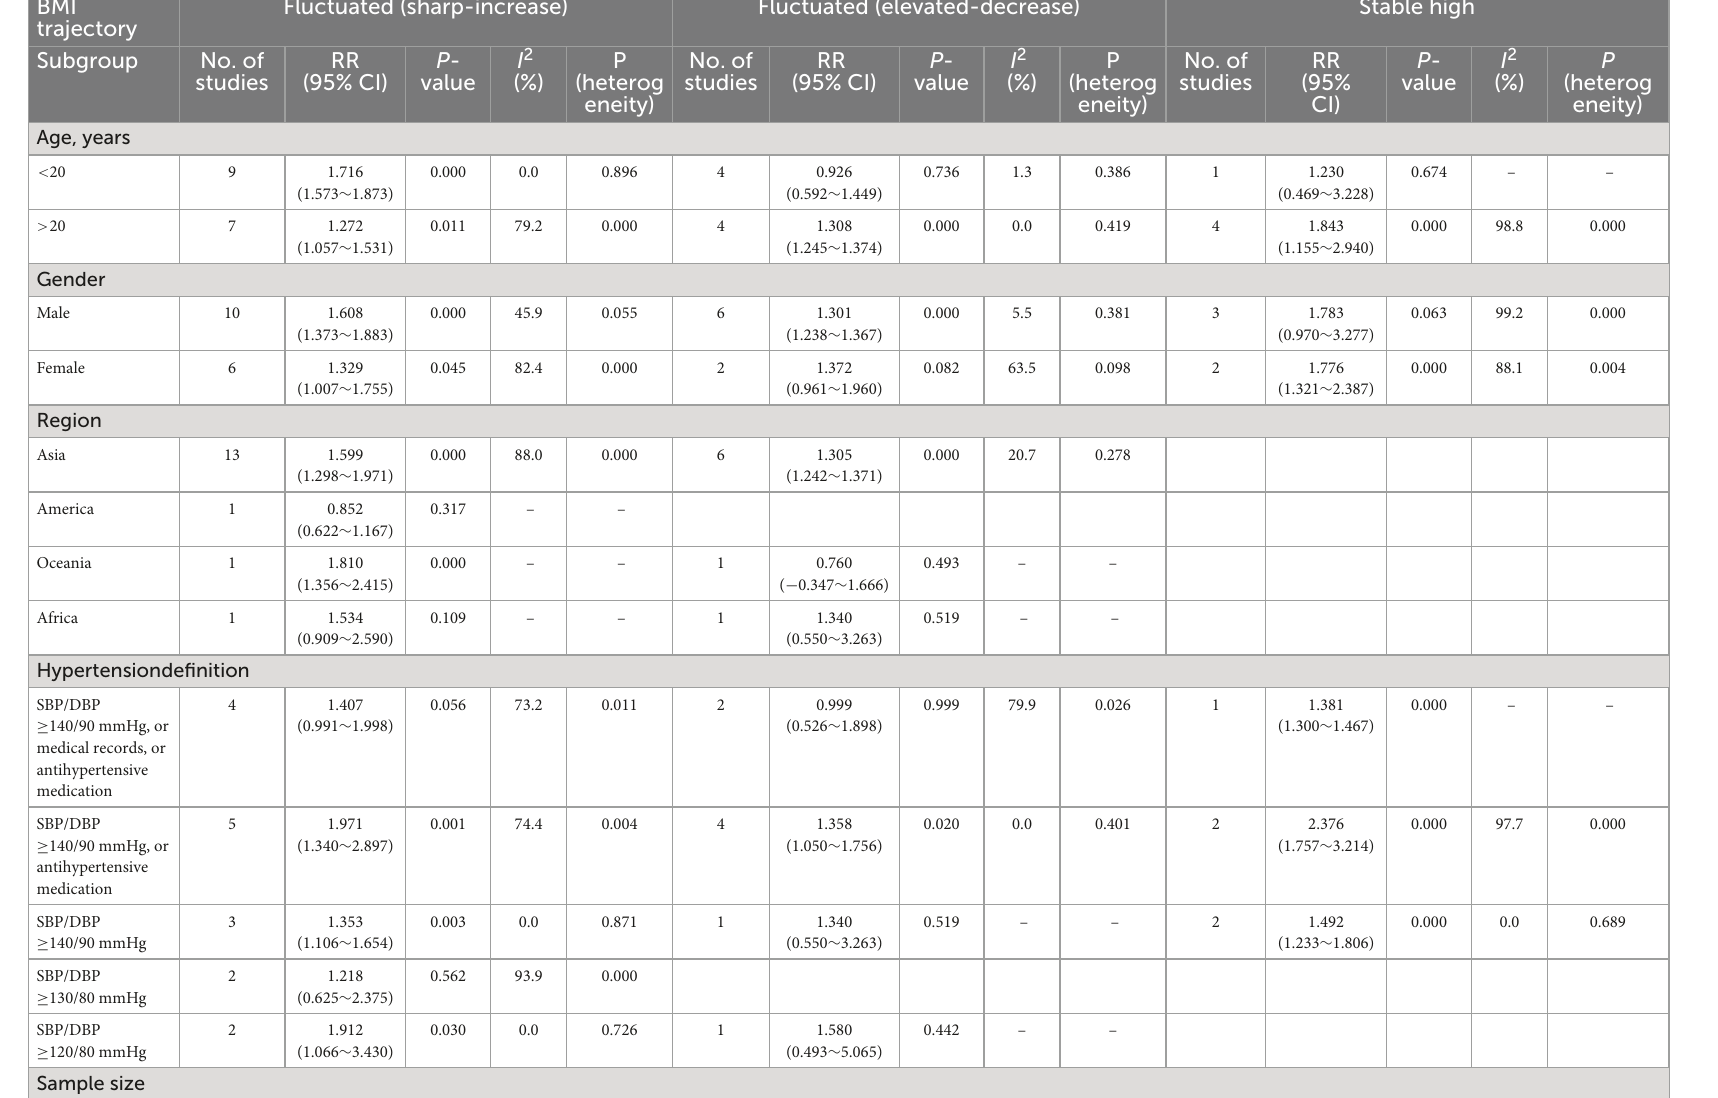
TABLE 5 Relationships between different body mass index (BMI) trajectories and risk of hypertension based on subgroup analysis. BMI